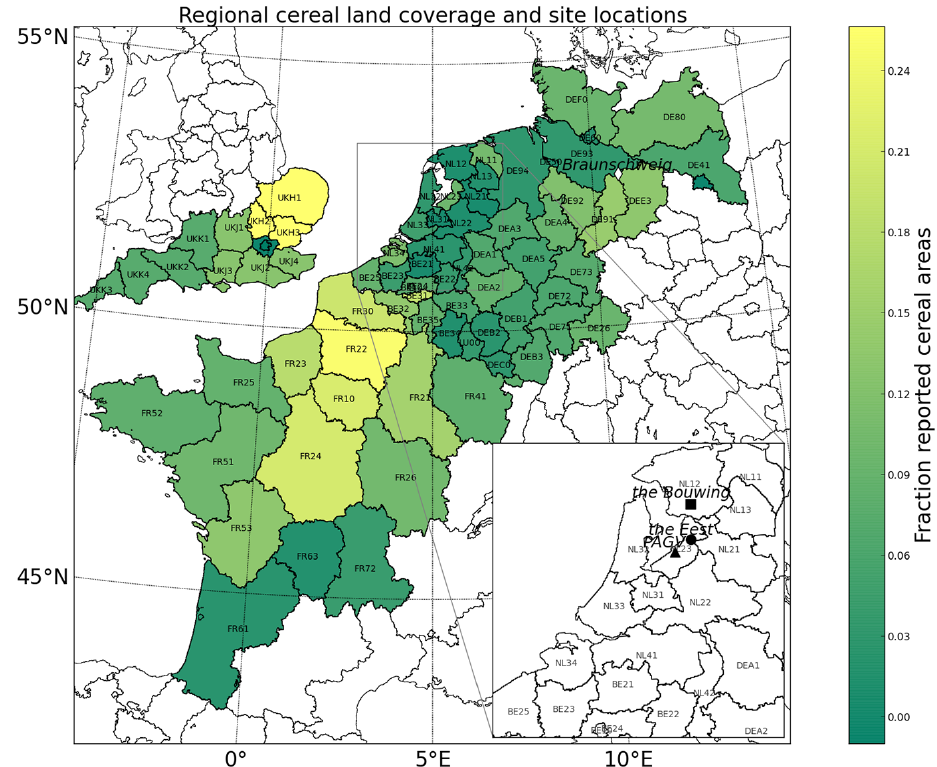
Figure A2. The fractions of cereal land in each selected region from EUROSTAT with region names as labels, also the locations of the trials described in Sect. 3.1 and the FACE experimental